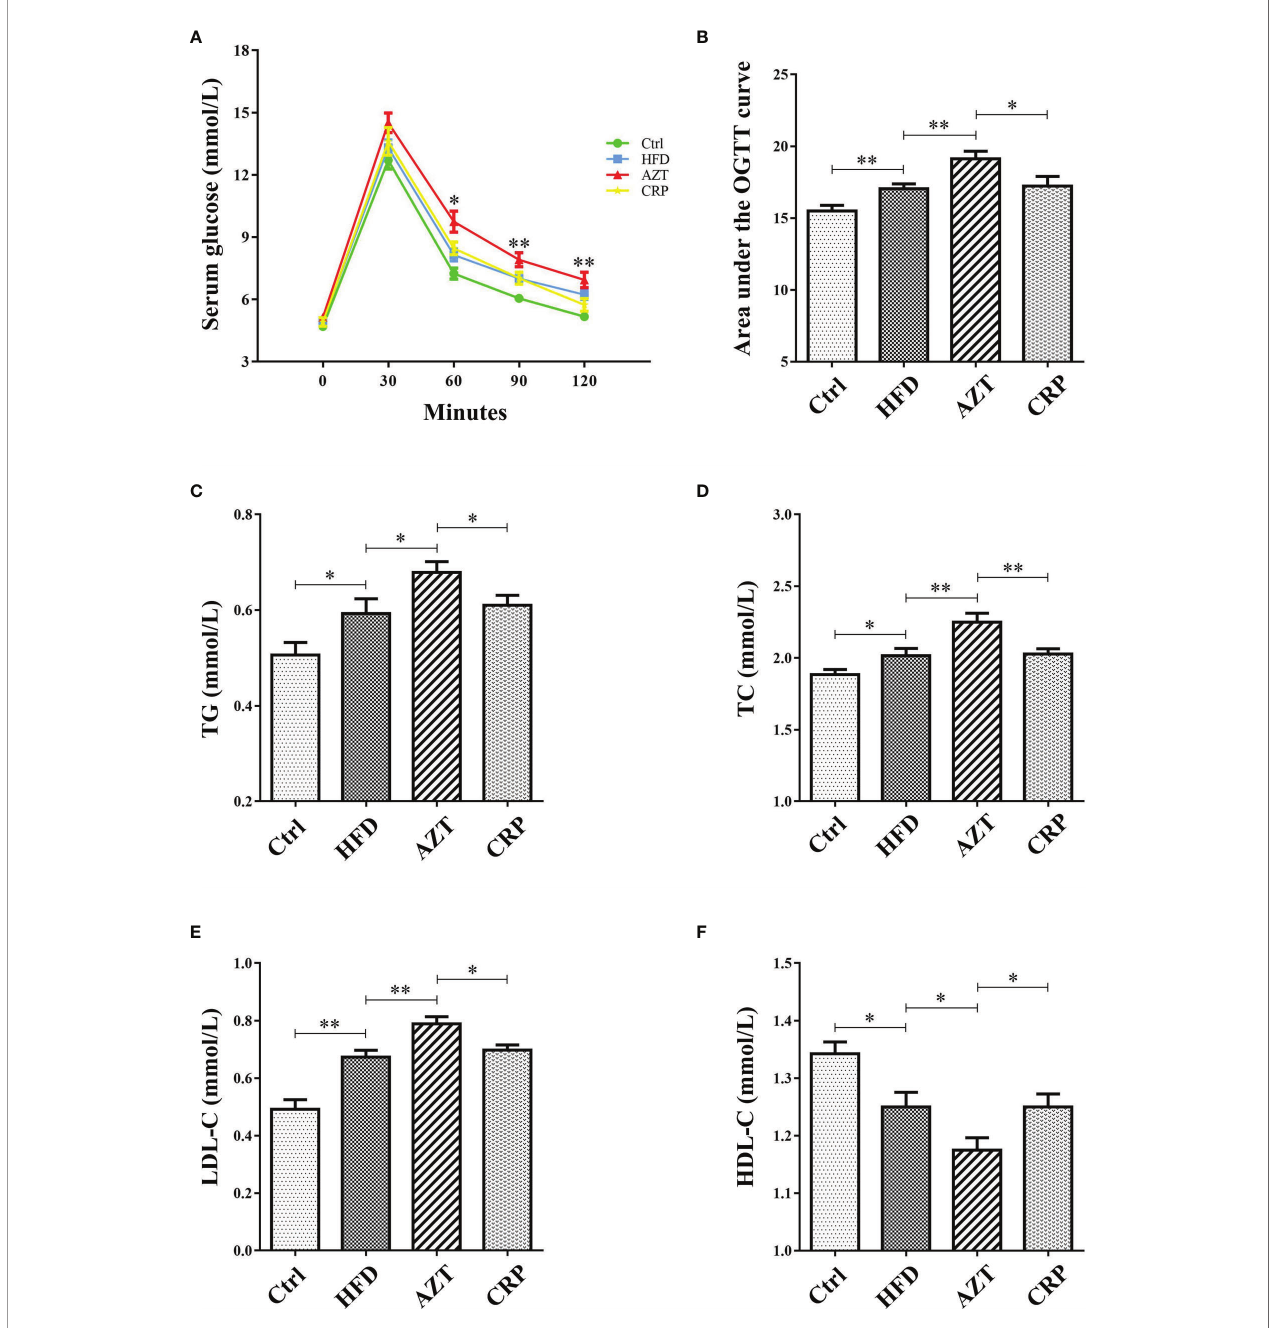
FIGURE 4 | Indices of glycolipid metabolism between the groups. (A) OGTT curve. (B) Area under the curve (AUC) of the OGTT. (C) Serum triglycerides (TG). (D) Serum total cholesterol (TC). (E) Serum low-density lipoprotein-cholesterol (LDL-C). (F) Serum high-density lipoprotein-cholesterol (HDL-C). Differences were assessed by ANOVA. Data are expressed as the mean ± SEM, n = 10 in each group. *P < 0.05, **P <